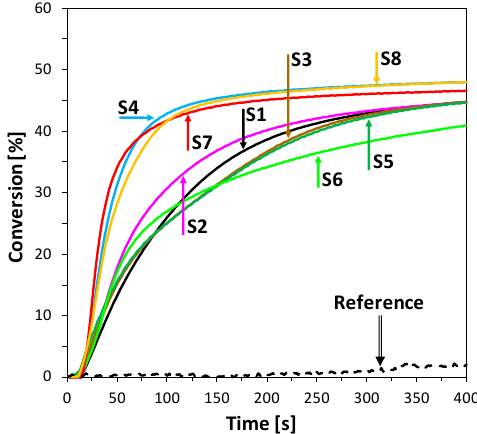
Figure 9. Conversion of SH bonds of trimethylolpropane tris(3-mercaptopropionate) MERCAPTO recorded during thiol-ene photopolymerization with PISs based on HIP (1 wt.%) and 2-amino-4,6-diphenyl-pyridine-3-carbonitrile derivatives (0.1 wt.%) under UV-LED 365 nm (intensity at the surface of sample 1.59 mW/cm 2 ) irradiation. The irradiation starts at t = 10 s. The final monomer conversion after only 400 s of irradiation is summarized in Table 3. During the thiol–ene process, the values of conversion of the methacrylate monomer reached 95%, while the conversion of thiols was at 47% (Table 3). The addition of the thiol monomer yielded high conversion values for the methacrylic monomer through the elimination of negative oxygen influence. Table 3. Functional group conversions using bimolecular photoinitiating systems. (A) Photo-oxidation mechanisms of photopolymerization: diphenyliodonium hexafluorophosphate (HIP 1 wt.%) and 2-amino-4,6-diphenyl-pyridine-3-carbonitrile derivatives (0.1 wt.%) as photosensitizers; (B) photo-reduction mechanisms: 4-(dimethylamino)benzoate (EDB 1.5 wt.%) and 2-amino-4,6-diphenyl-pyridine-3-carbonitrile derivatives (0.1 wt.%). A c r o n i m